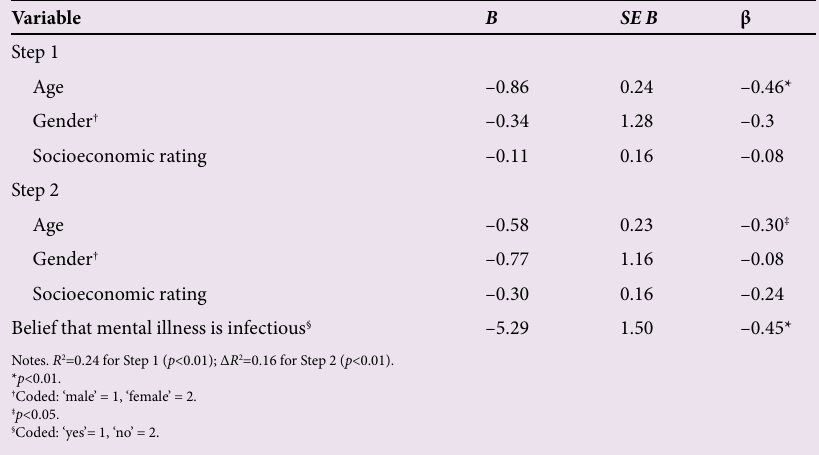
Table 3. Regression coefficients for independent predictors of Short Mood and Feelings Questionnaire